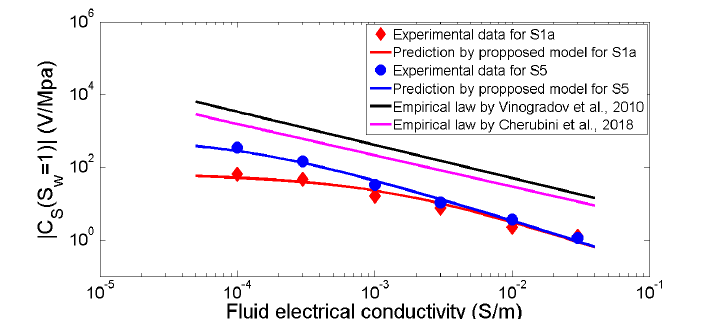
Figure 7. The variation of the SPCC at full saturation with the fluid electrical conductivity for two glass bead pack (S1a and S5) saturated with NaCl solutions (see symbols) taken from the work in [99]. The solid lines are predicted from Equation (26) and two empirical laws proposed by Vinogradov et al. [33] and by Cherubini et al.